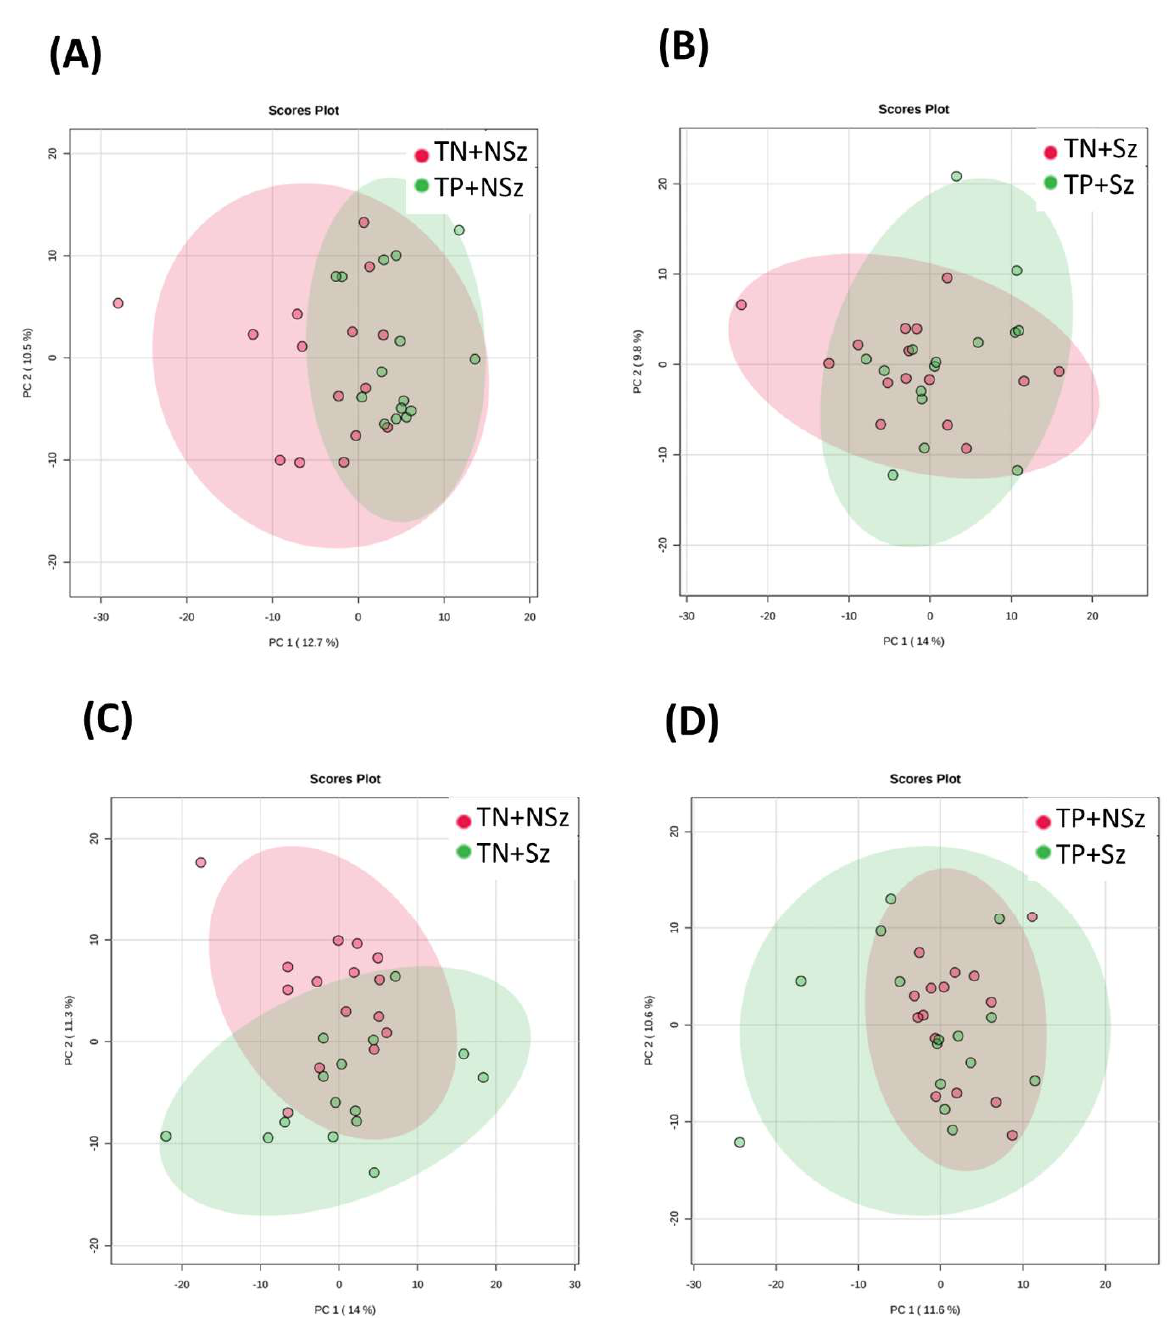
Figure 2. Distribution of the plasma samples from negative mode in PCA score plots for differ- ent group comparisons. Comparisons were made for ( A ) TP+NSz vs. TN+NSz, ( B ) TP+Sz vs. TN+Sz, ( C ) TN+Sz vs. TN+NSz and ( D ) TP+Sz vs. TP+NSz. TP+NSz: non-schizophrenia subjects with Toxo- plasma infection; TN+NSz: non-schizophrenia subjects without Toxoplasma infection; TP+Sz: schizo- phrenia subjects with Toxoplasma infection; TN+Sz: schizophrenia subjects with Toxoplasma infec- tion.